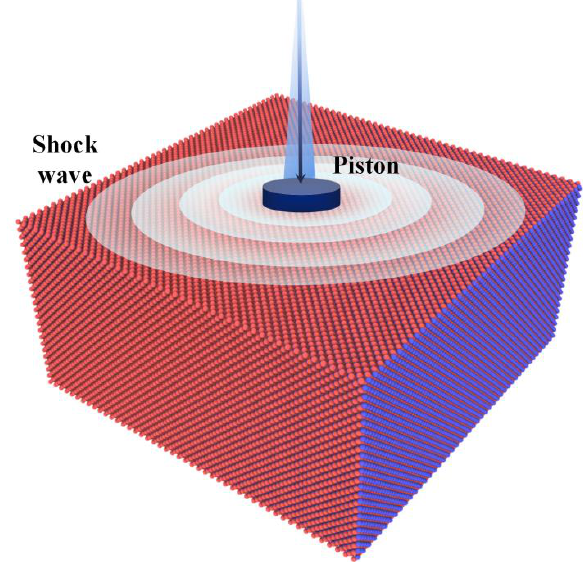
Figure 15. The typical shock damage simulation model of SiC [94].